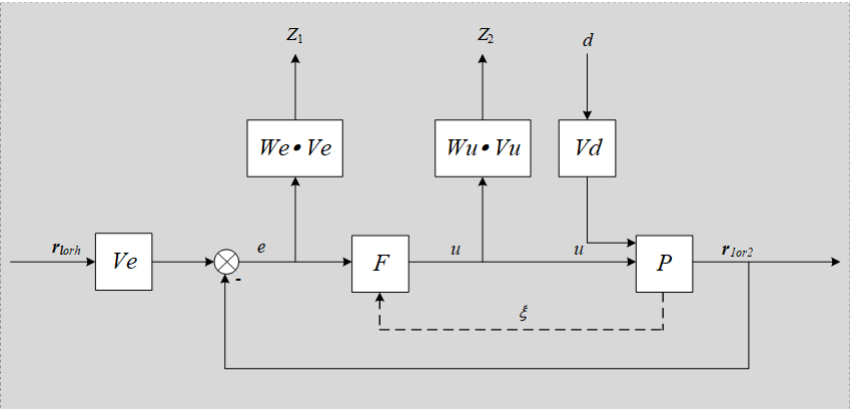
Figure 3. Block diagram of mixed-sensitivity